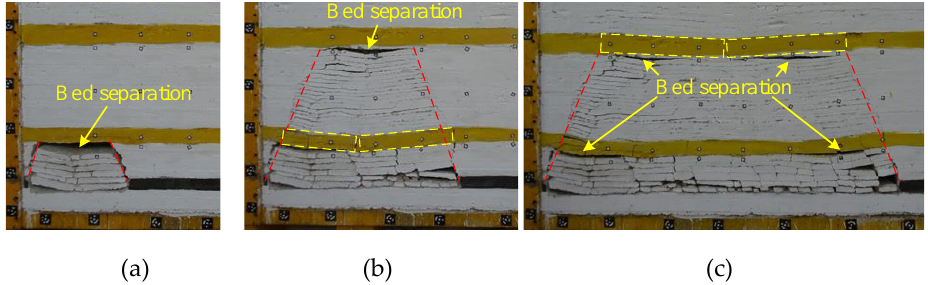
Figure 6. Collapse of the immediate roof, SKS and the PKS due to mining. ( a ) Immediate roof caving; ( b ) SKS breakage; ( c ) PKS breakage.